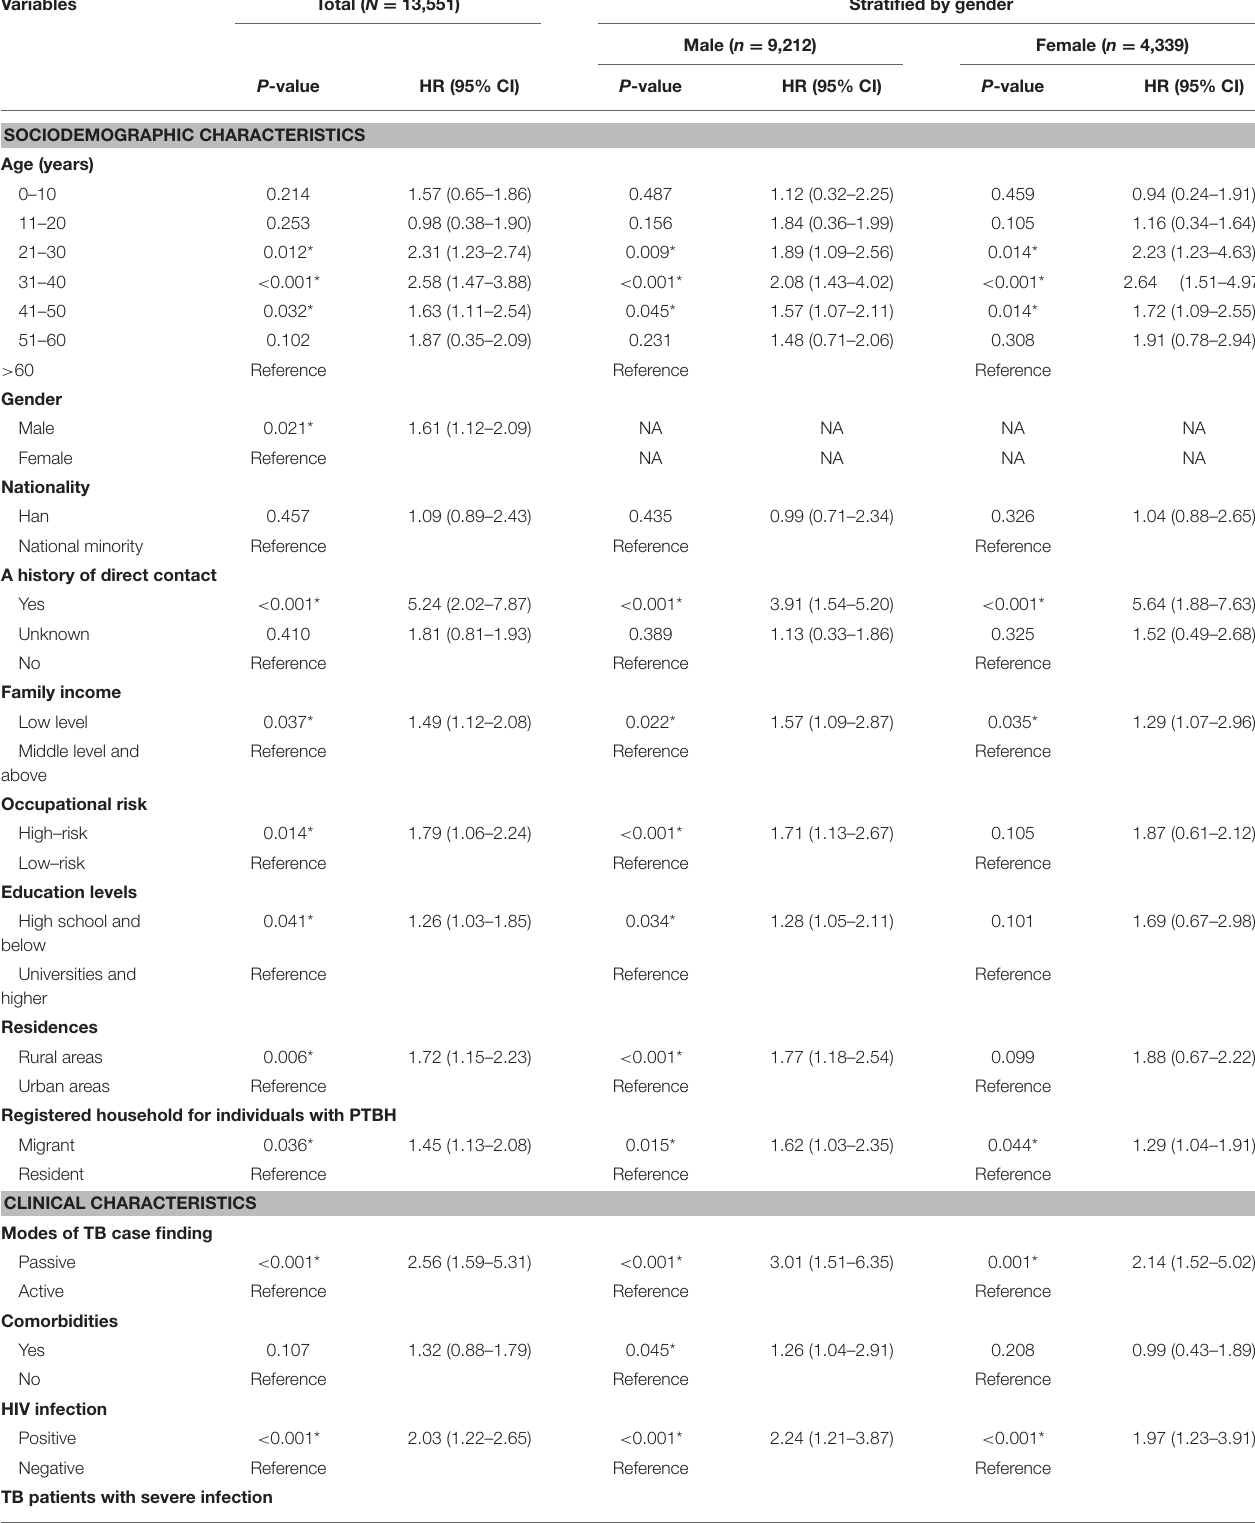
TABLE 4 | Univariate Cox regression analysis of risk factors of MDR-TB among individuals with PTBH in Hangzhou, China.